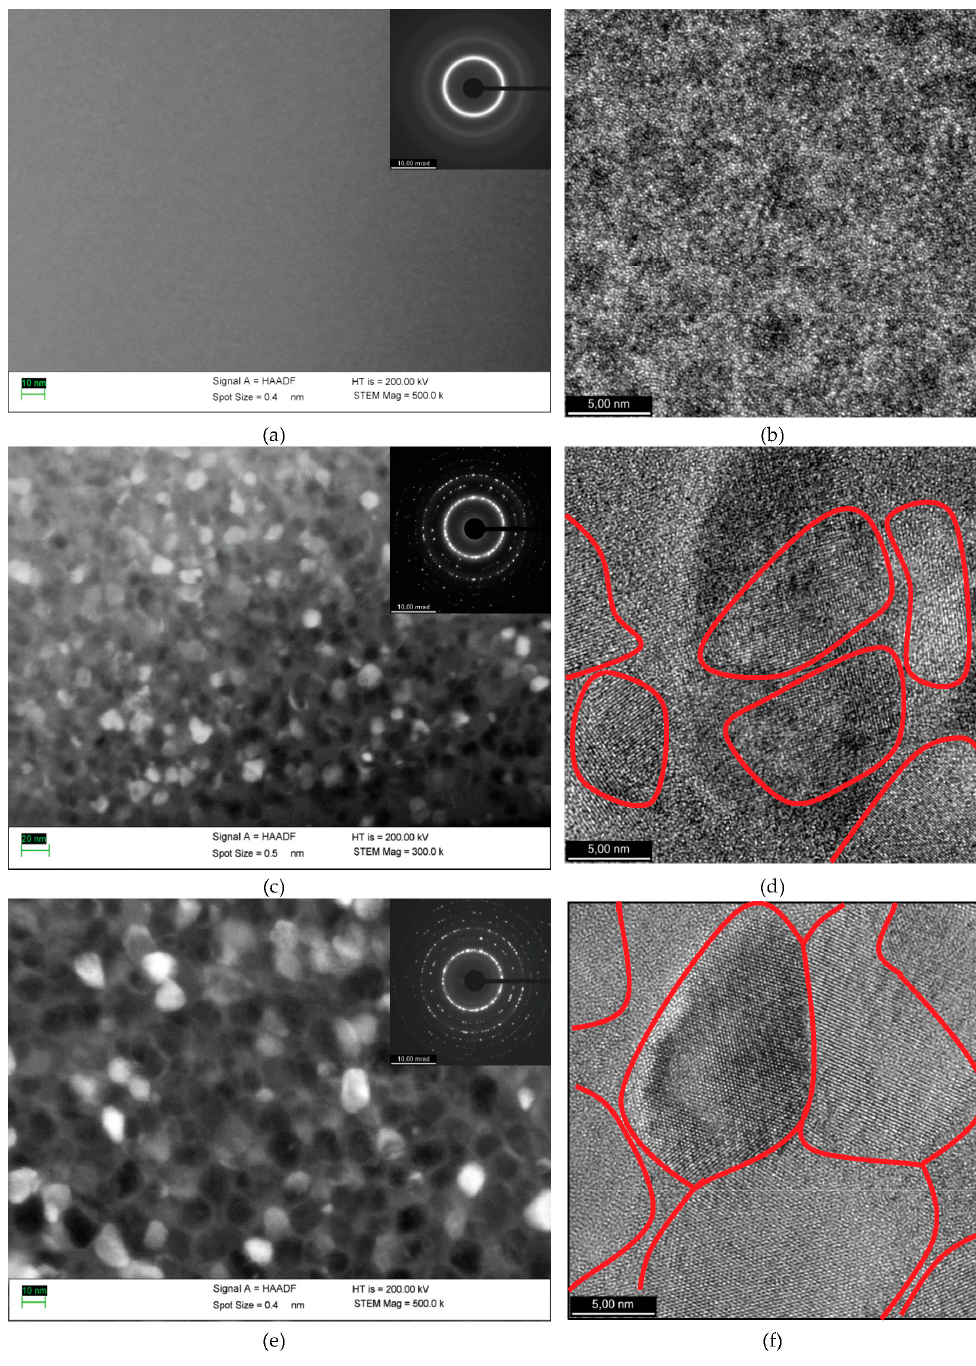
Figure 11. Evolution of the microstructure of a FINEMET nanowire having the metallic nucleus diameter of 320 nm: ( a ) STEM and SAED images and ( b ) UHR-TEM image for the as-cast amorphous sample; ( c ) STEM and SAED images and ( d ) UHR-TEM image for the sample annealed at 550 °C for 60 min.; ( e ) STEM and SAED images and ( f ) UHR-TEM image for the sample annealed at 600 °C for 60 min.